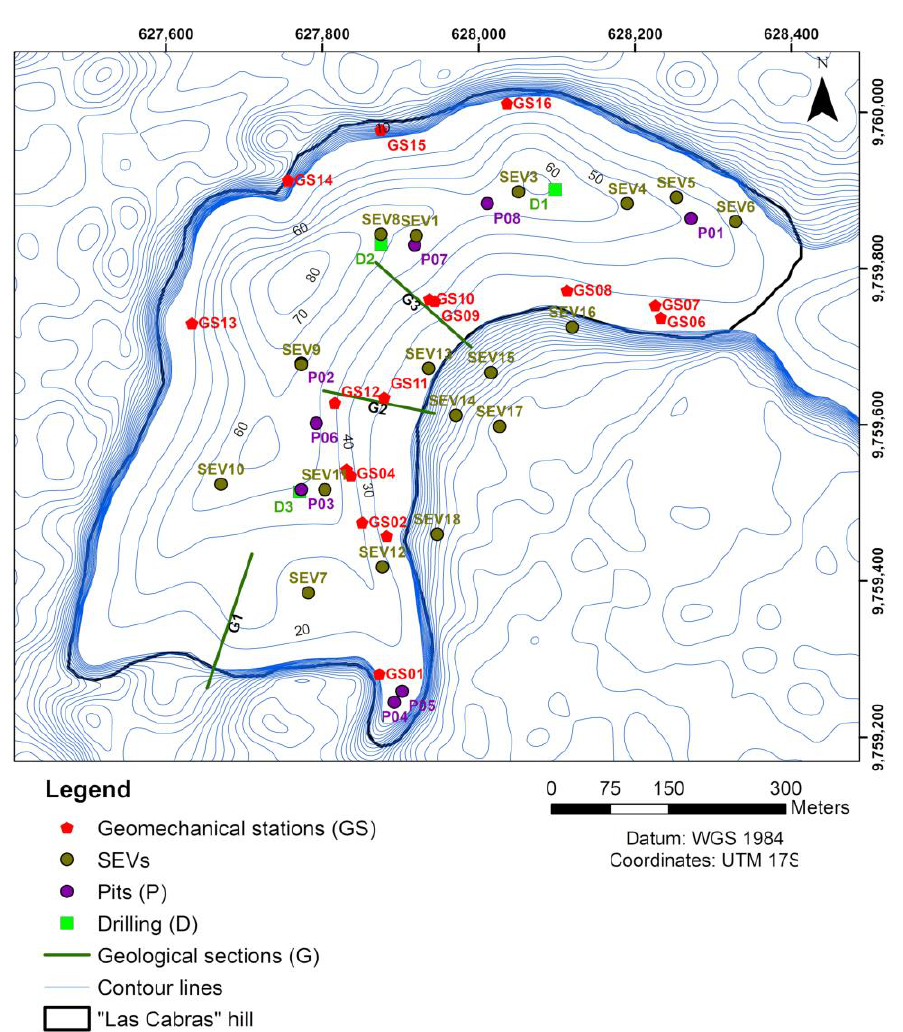
Figure 3. Locations of sites for geological and geomechanical characterisation studies.